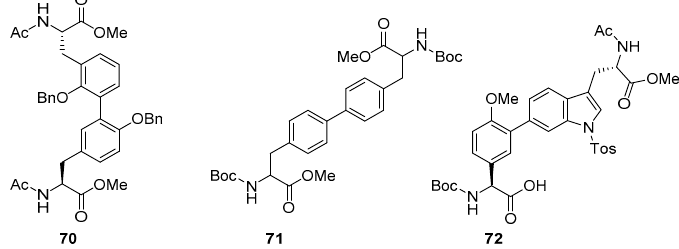
Figure 11. Amino acid homo- and heterodimers 45 – 47 by intermolecular Suzuki–Miyaura Figure 10. Amino acid homo- and heterodimers 45 – 47 by intermolecular Suzuki–Miyaura cross-coupling.